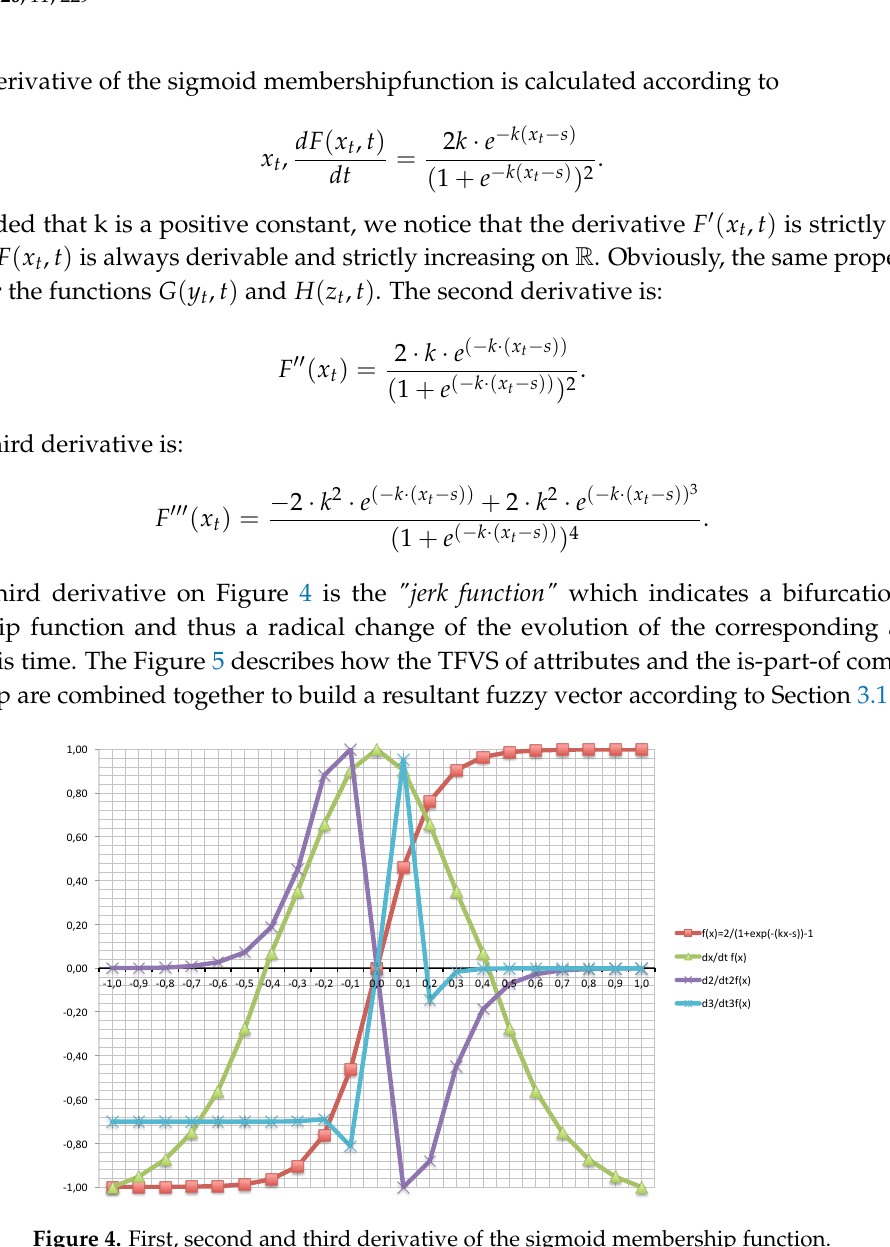
Figure 4. First, second and third derivative of the sigmoid membership function.